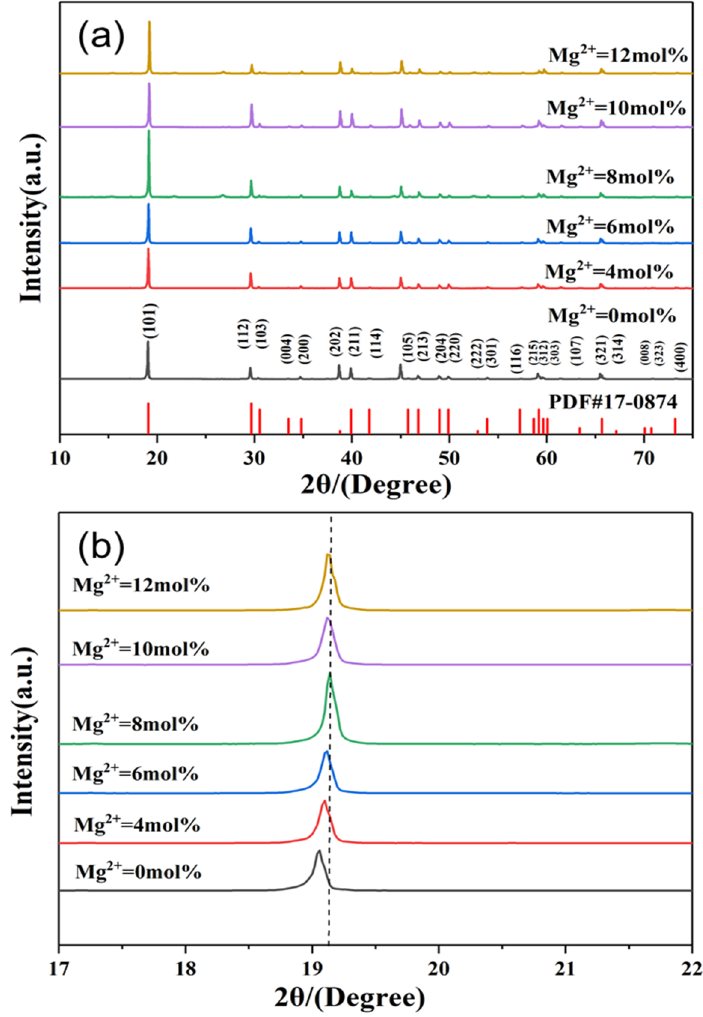
Figure 1. ( a ) XRD diffraction pattern of Mg 2+ -doped LiYF 4 :Yb 3+ /Ho 3+ UCMPs; ( b ) diffraction peak of Mg 2+ -doped LiYF 4 :Yb 3+ /Ho 3+ UCMPs around 19°.